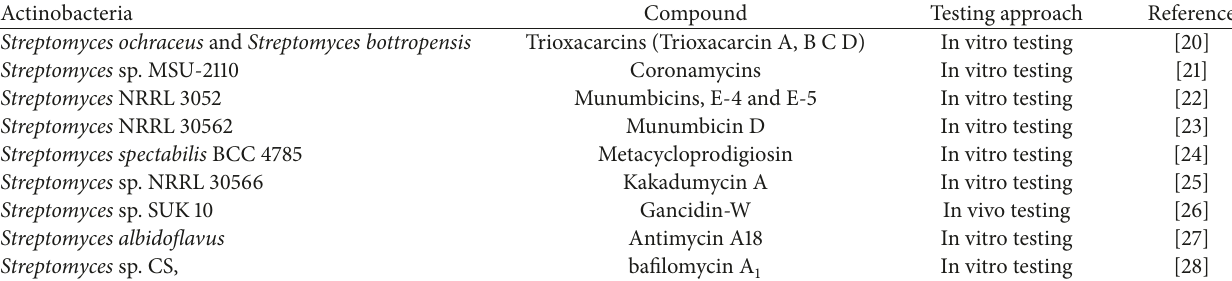
Table 1: List of antimalarial agent sources and their biological